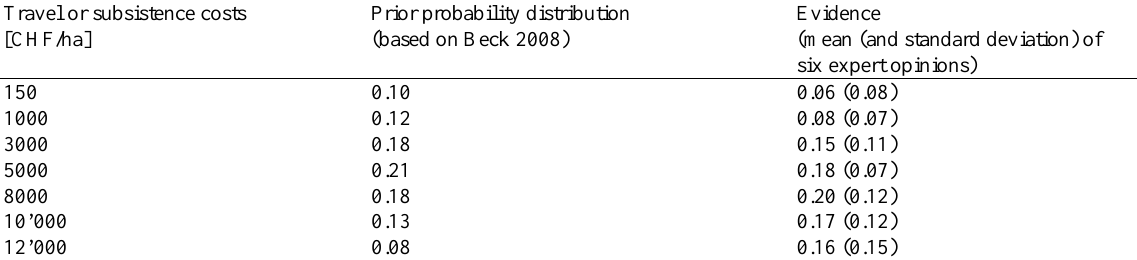
Table A3.4. Prior probability distribution of travel and subsistence costs of forests and evidence provided by experts. The evidence that was fed into the Bayesian Network was calculated as the mean value of the probability estimates for each state of the node provided by the single